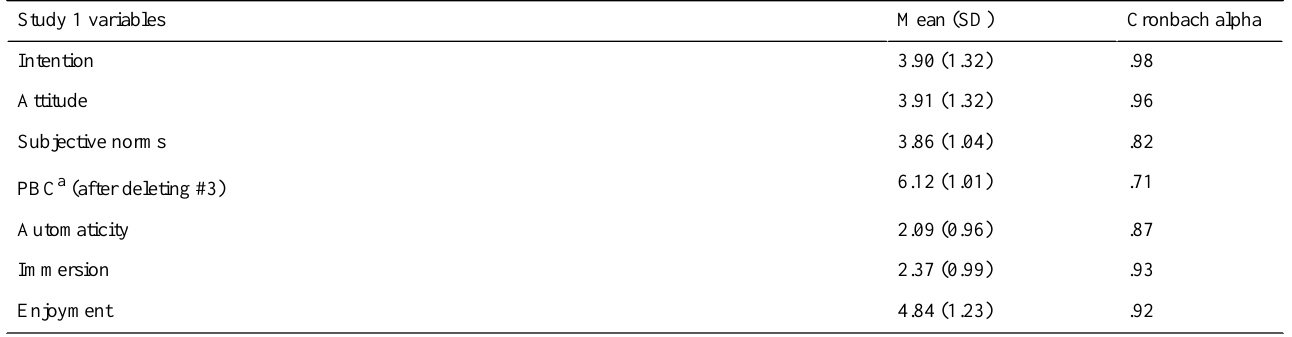
Table 1. Means, standard deviations, and Cronbach alphas for study 1 variables.